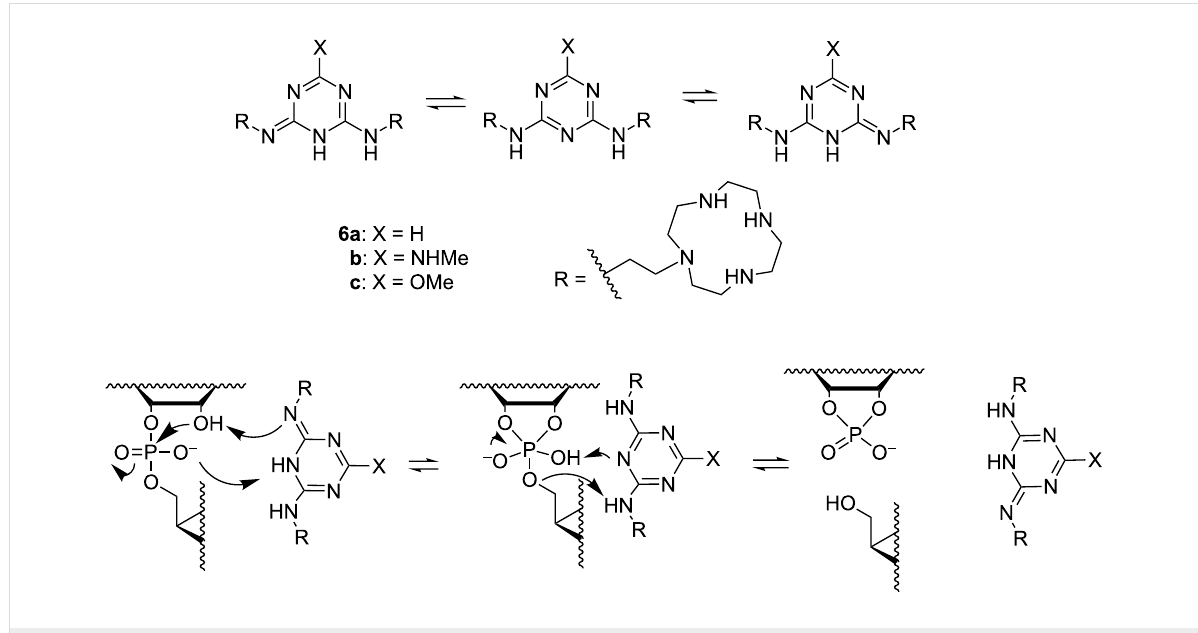
Scheme 7: Tautomers of triazine-based cleaving agents and cleavage of RNA phosphodiester bonds by these agents [78].